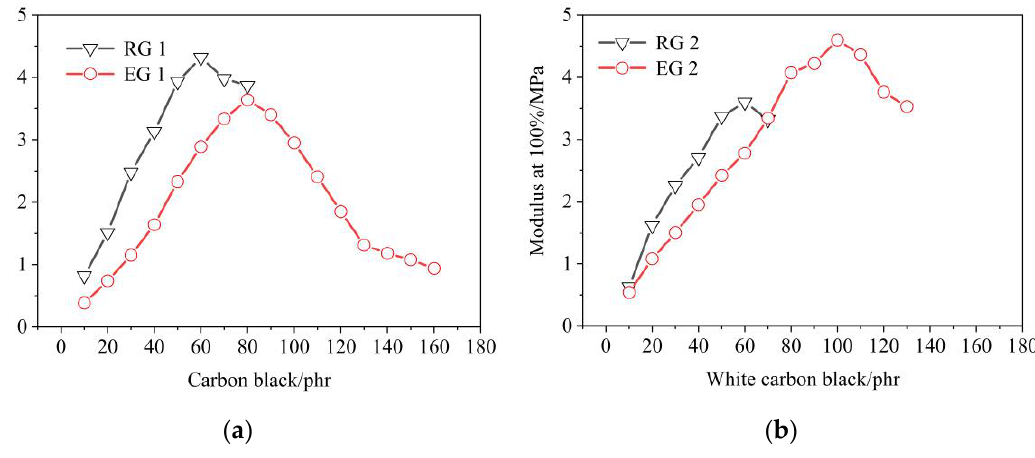
Figure 7. Effect of filler on the modulus at 100% of rubber samples. RG 1 and EG 1 were for SBR rubber mixtures; RG 2 and EG 2 were rubber mixtures based on NR rubber. ( a ) Effect of CB on the modulus at 100% of rubber samples; ( b ) Effect of WCB on the modulus at 100% of rubber